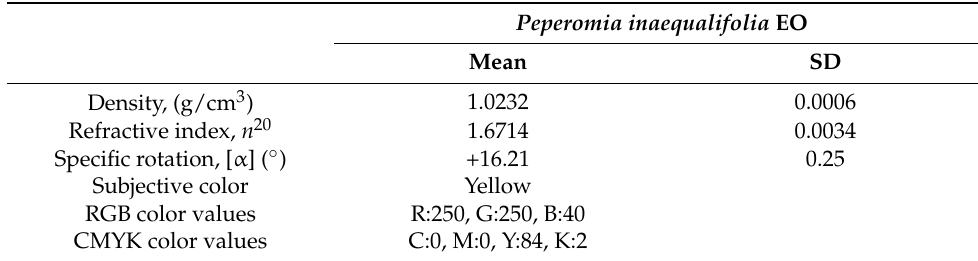
Table 1. Physical properties of the essential oil of Peperomia inaequalifolia .